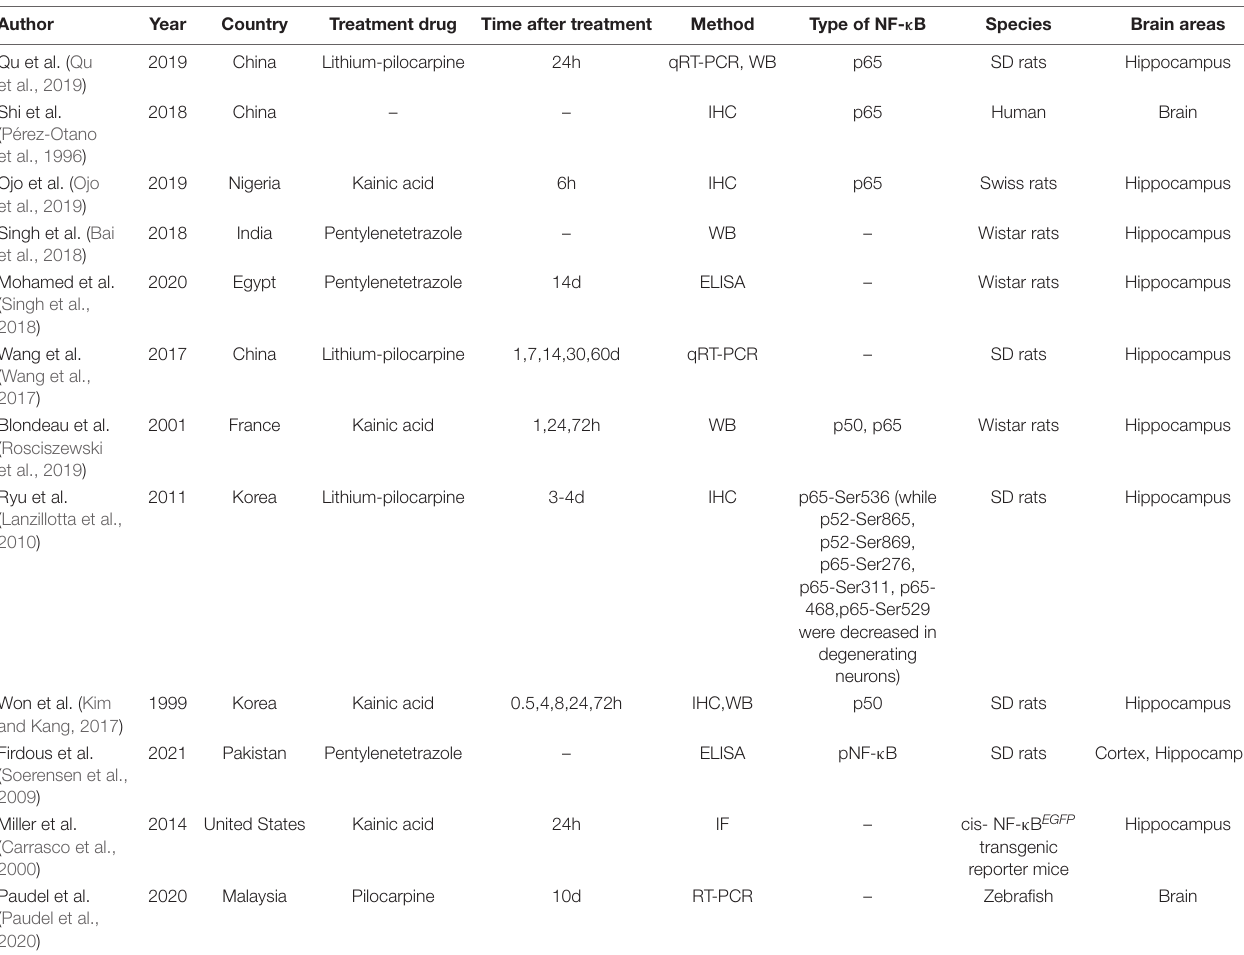
TABLE 1 | NF- κ B proteins with abnormal expression and/or activity associated with